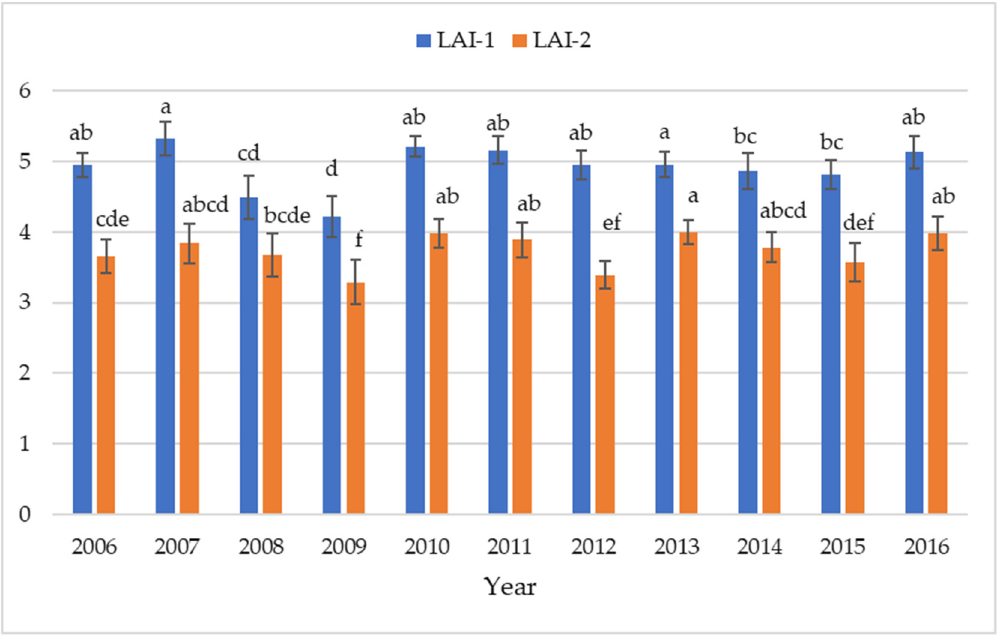
Figure 1. Leaf Area Index (±SD) of sugar beet before first fungicide spraying (LAI-1) and before harvest (LAI-2) in the study years; a–f—the same letters indicate no significant differentiation.